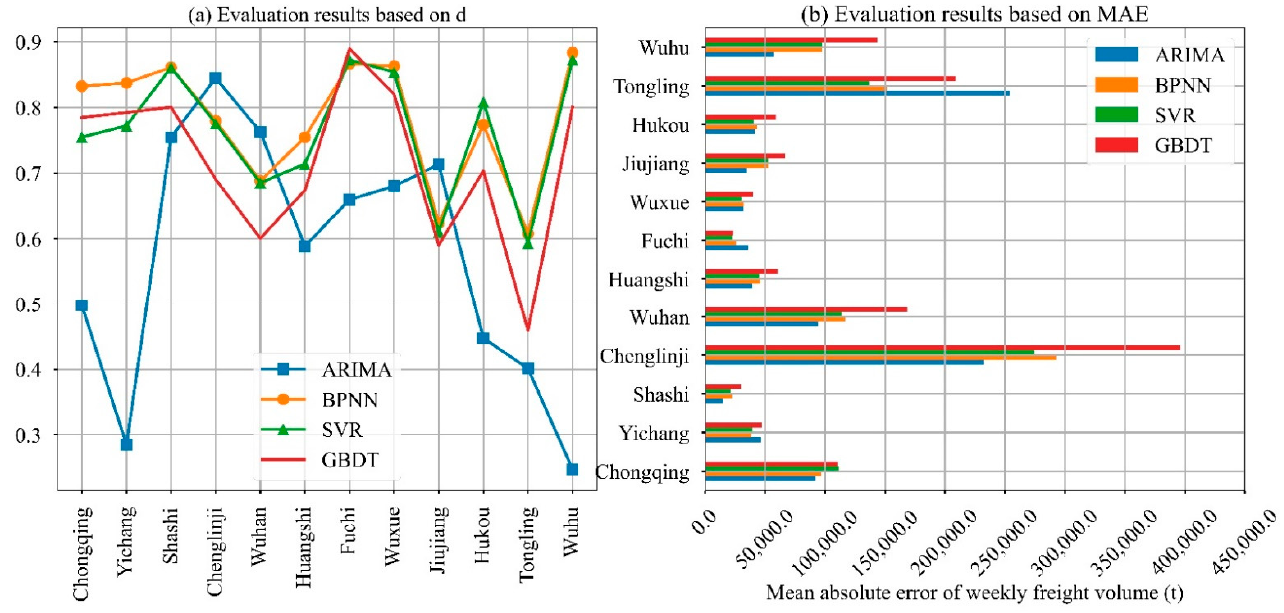
Figure 10. Evaluation results of predictions based on four basic forecasting models. Table 4. Evaluation results of predictions based on SVR, SVR-GBDT, and